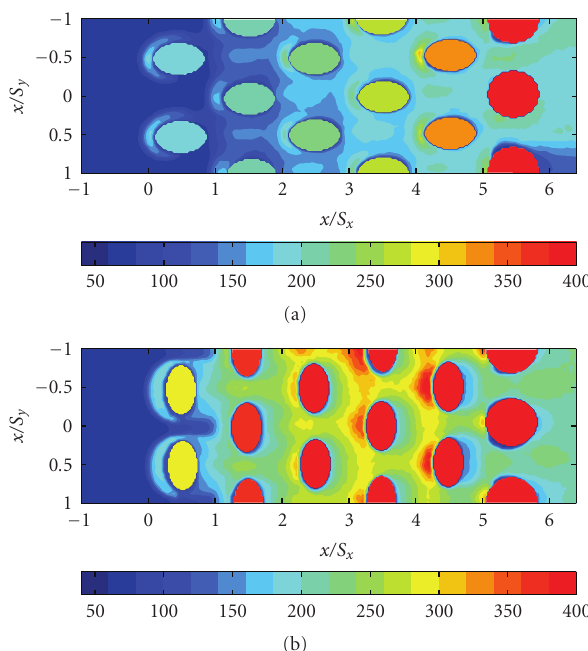
Figure 4: HTC [W / m 2 K]map of elliptic configurations—Re d 5 = 18000.